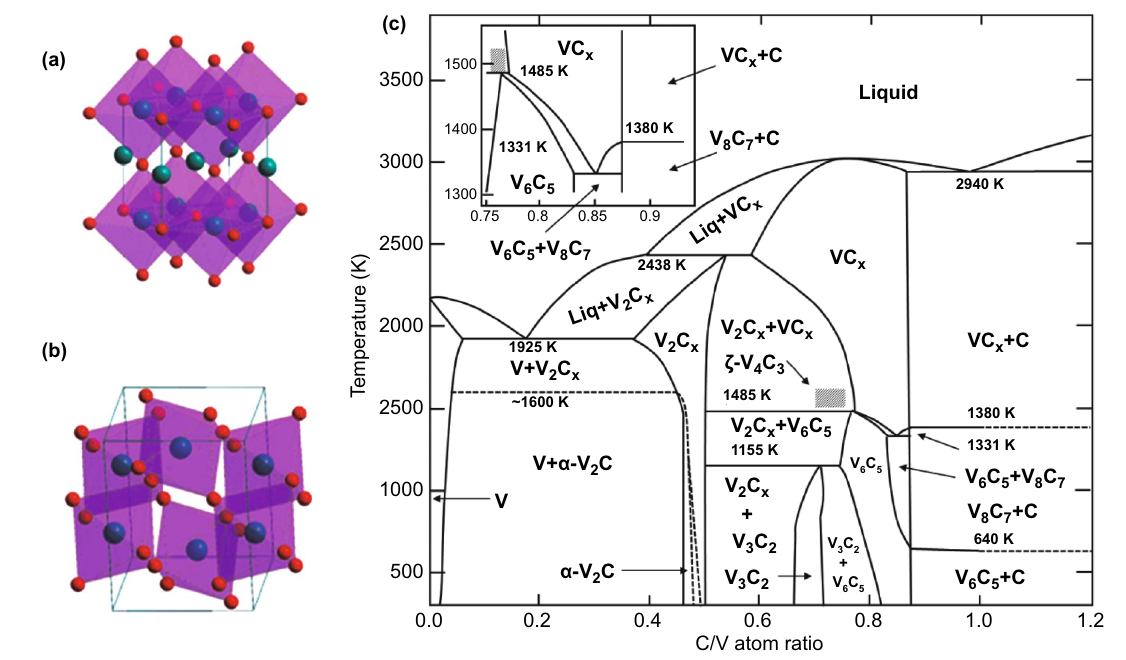
Fig. 3 Crystal structure of V-based TMCs. a VC, b α-V 2 C. Reproduced with permission from Ref. [30]. Copyright 2011, The Royal Society of Chemistry. c Phase diagram of C-V system. Reproduced with permission from Ref. [31]. Copyright 1989, IOP